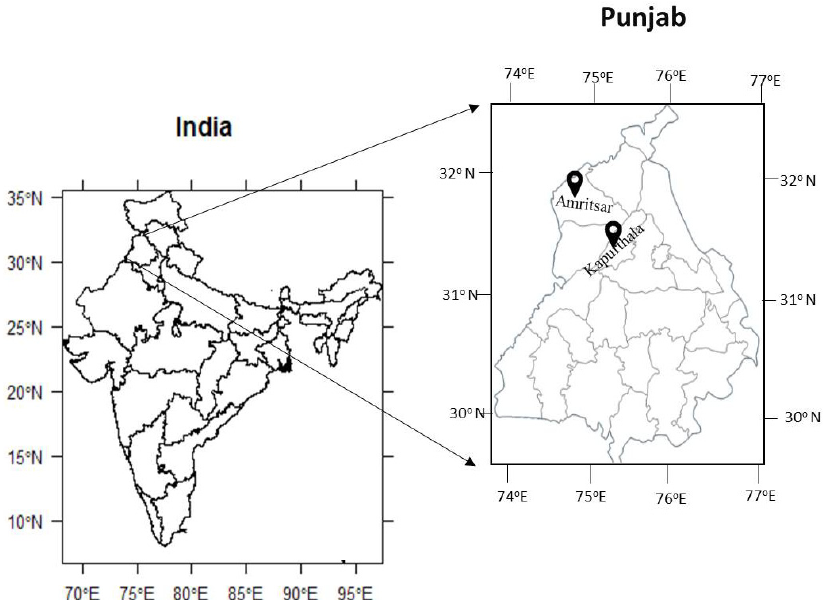
Figure 1. Map representing the sample collection sites of Majha and Doaba regions in Punjab, In-